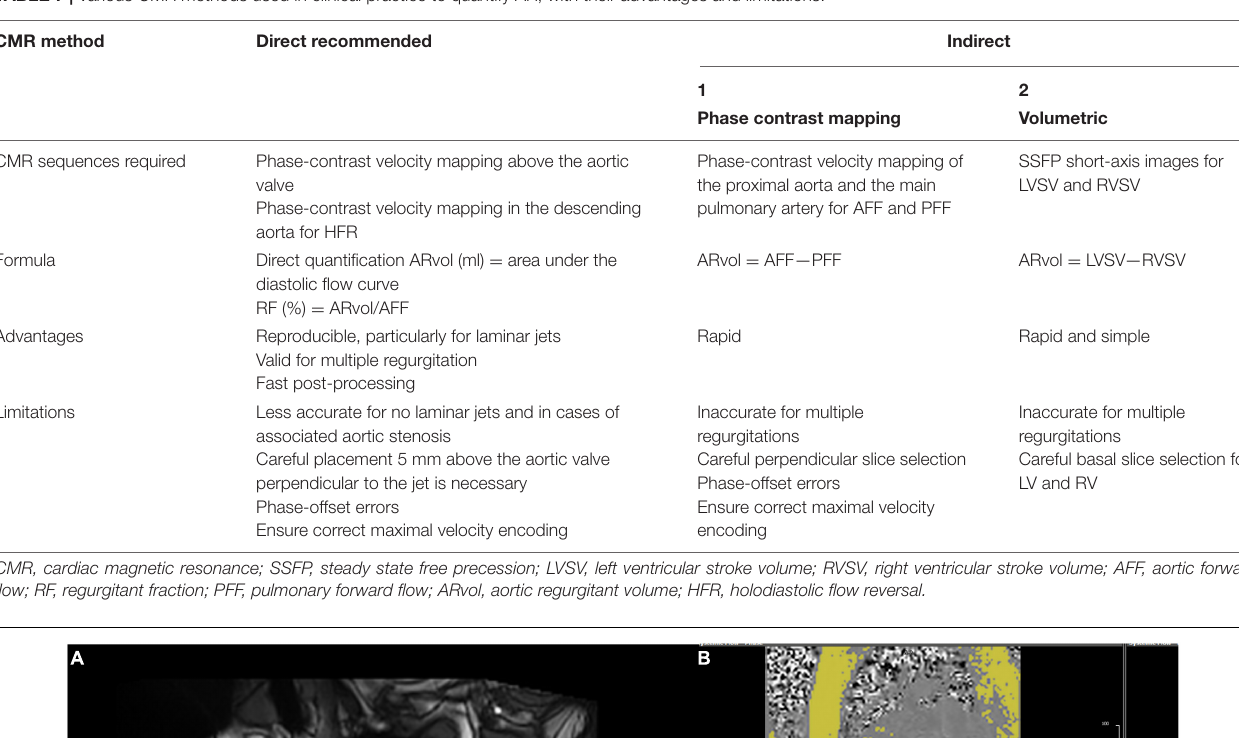
TABLE 7 | Various CMR methods used in clinical practice to quantify AR, with their advantages and limitations.